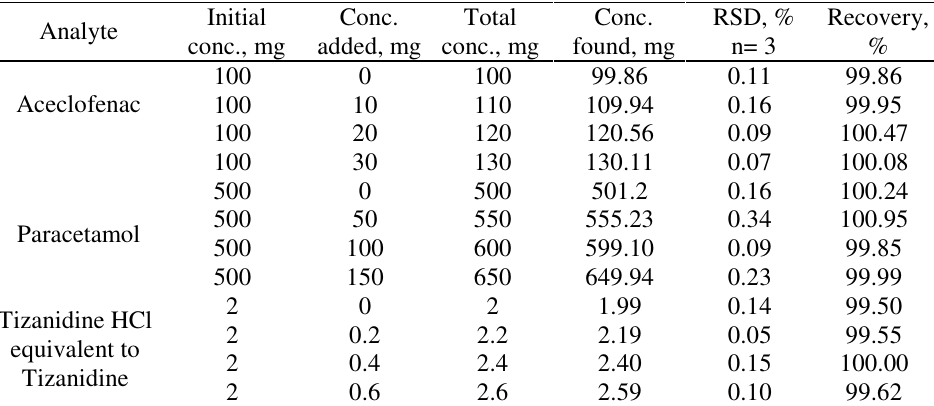
Table 4. Accuracy of the